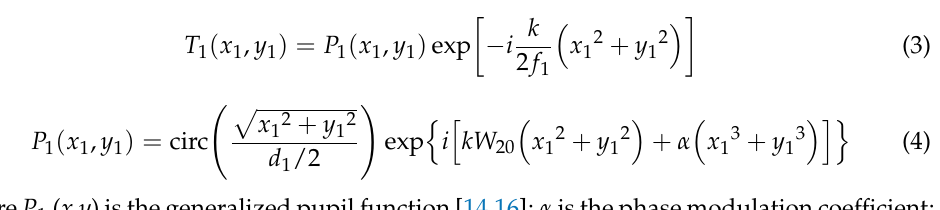
where ω 0 is the Gaussian beam waist; k and λ are the wave number and the laser wave- length, respectively; ω ( z ) and R ( z ) are the spot size and the equiphase surface curvature radius of the Gaussian beam wavefront on the front surface of the imaging lens, respec- tively.